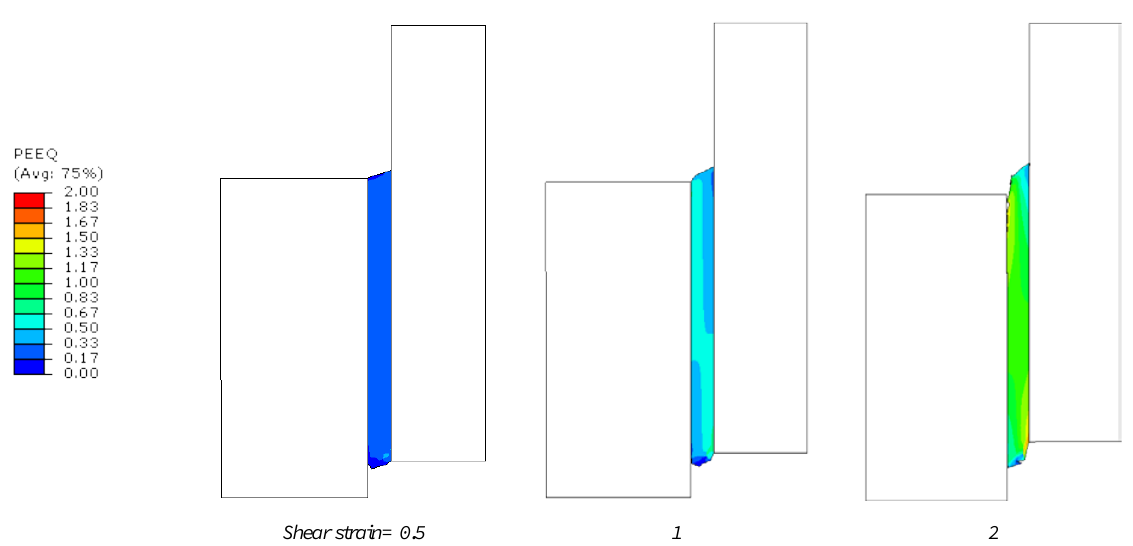
Fig. 8 Evolution of plastic yielding in the M0C model (ABAQUS, 1/4 specimen), with δ f =1.5mm and t 0 =8MPa the CZM input. Even under large strain ratios, see Figure 9, stress peaks in the direction perpendicular to the bonded surfaces are mainly located at the ends of the overlapping region, as also expected from earlier research studies (see section 2.2).